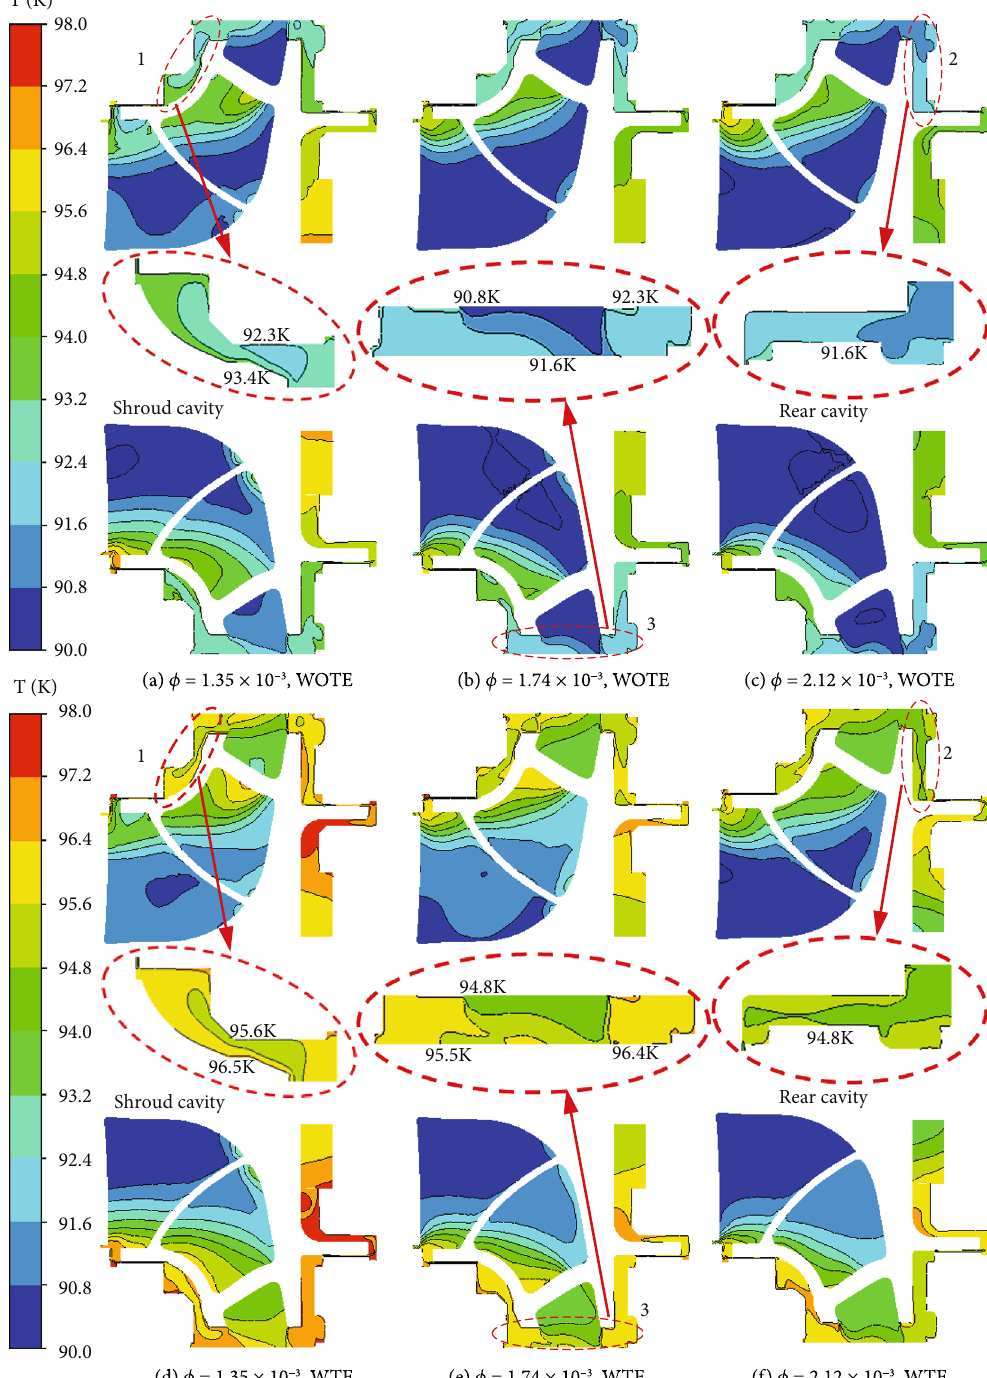
Figure 14: Comparison of the temperature with and without thermodynamic e ff